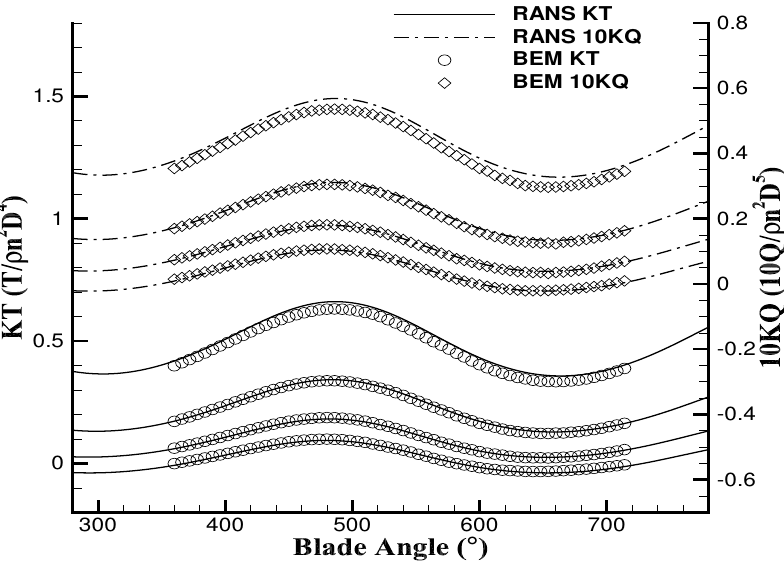
Figure 13. Predicted DTMB 4661 propeller forces by BEM using the unsteady wake alignment scheme, in comparisons with RANS results in 10 ◦ inclined shaft flow at the advance ratio of 0.8, 1.0, 1.2, and 1.4 from top to bottom lines for every pair of KT and 10 KQ